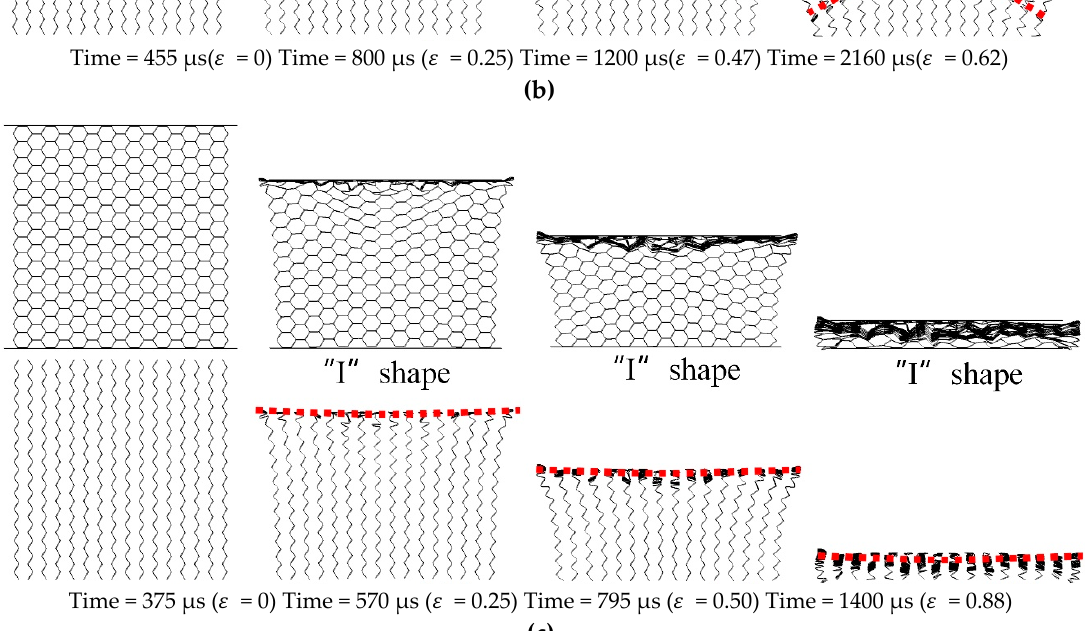
Figure 5. Deformation characteristics in the X1 -RP-H-RP. ( a ) Overall response mode, ( b ) Transitional response mode, and ( c ) Local response mode .